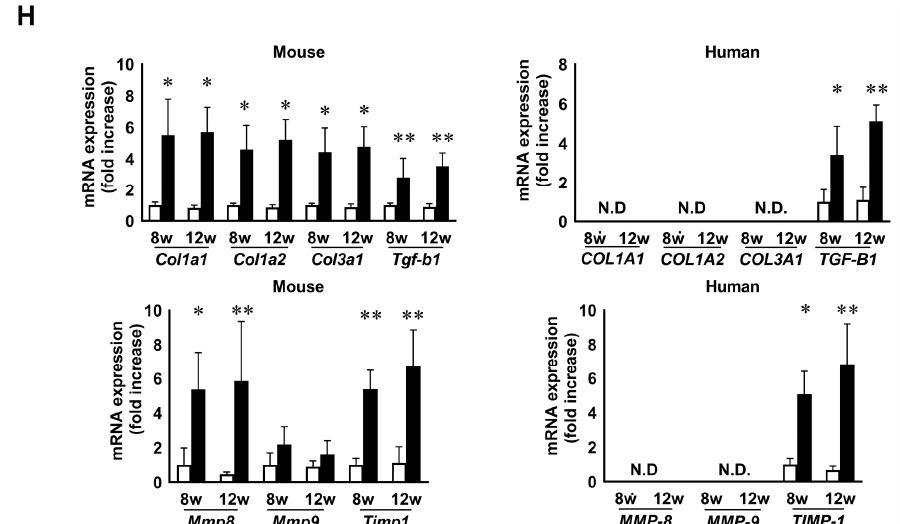
Figure 4. Fibrosis in human chimeric mice after CDAHFD feeding. Representative images of Sirius Red ( A ) and silver ( B ) staining in the livers of the control and CDAHFD groups at 12 weeks. Scale bar: 100 μ m (upper), 50 μ m (lower). The ratio of the Sirius red-positive area in the livers of the control and CDAHFD groups at 8 or 12 weeks ( C ). Immunostaining with α SMA antibody in the livers of the control and CDAHFD groups at 12 weeks ( D ). Scale bar: 50 μ m. The ratio of the α SMA positive area in the livers of the control and CDAHFD groups at 8 or 12 weeks ( E ). Results are represented as the mean ± standard deviation ( n = 3). Changes in the levels of mouse Acta2 ( F ) in the livers of the control and CDAHFD groups at 8 and 12 weeks. Results are expressed as the mean ratio of each value to the control group at 8 weeks. Plasma Mac-2 binding protein levels in the sera of control and CDAHFD-fed mice at 8 and 12 weeks ( G ). Changes in the levels of fibrosis-related gene expression ( H ) in the livers of the control and CDAHFD groups at 8 and 12 weeks. Results are expressed as the mean ratio of each value to the control group at 8 weeks. Statistical comparison among multiple groups was evaluated using ANOVA, followed by Tukey’s post hoc test. * Significant difference from the control group ( p < 0.05). ** Significant difference from the control group (p < 0.01). *** Significant difference from the control group ( p < 0.001).